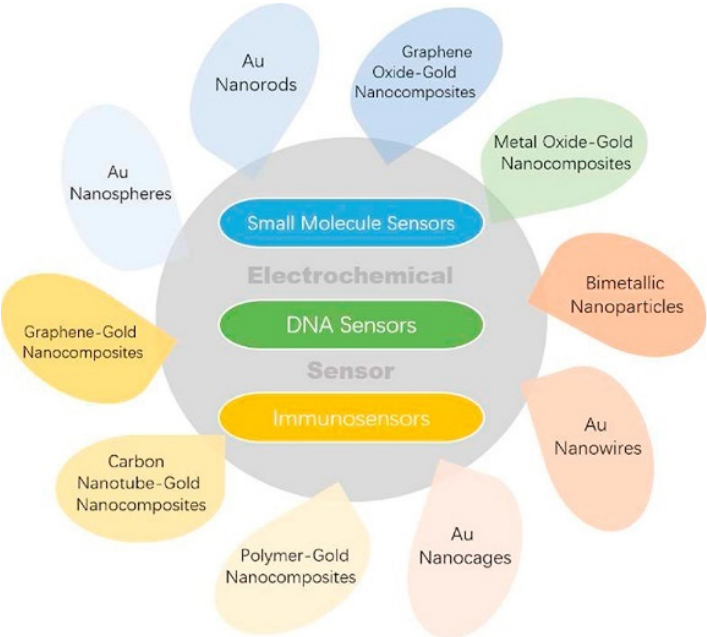
Figure 1. Electrochemical sensor applications of Au and Au-based nanomaterials. Reprinted with permission from [39] Copyright 2020, Elsevier.